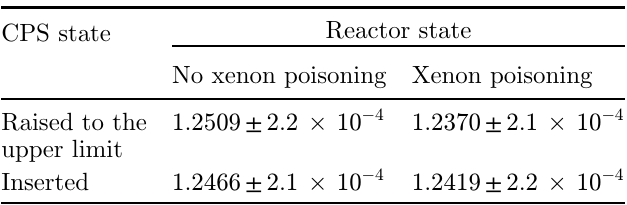
Table 1. Results of the insertion effect of control rods ( k ∞ values